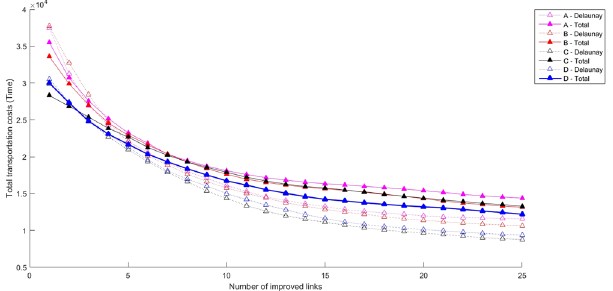
Figure 6. Total transportation costs for a region with 12 towns for the two types of connecting networks considered, the four geographical distributions and the three decision-making processes. Empty symbols: Delaunay triangulation. Filled symbols: Complete network. Node configurations: circunference (magenta), circunference with a center (red), double circunference with a center (black) and random (blue). The decision- making process is of type I (one town, one vote).